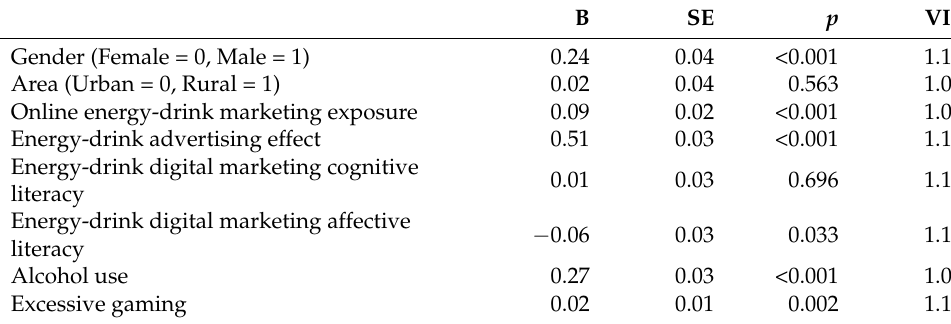
Table 2. Factors related to energy-drink